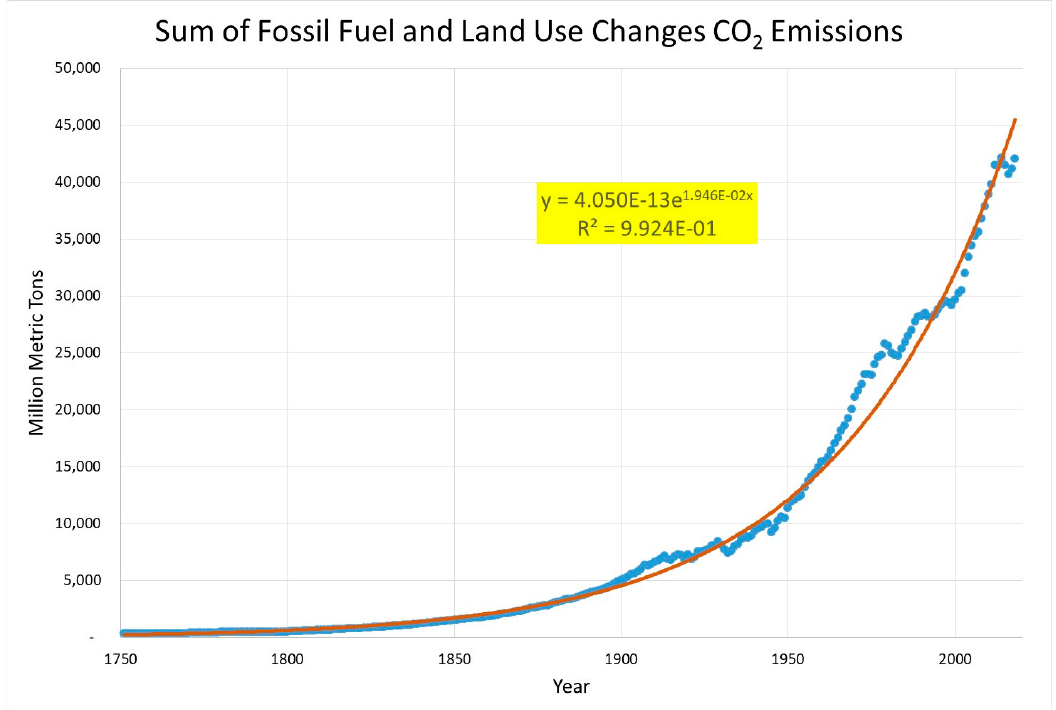
Figure 3. Global emission levels of CO 2 from fossil fuels and land-use changes; equation is best fit exponential curve to the data; R 2 in each figure defines the goodness of fit.